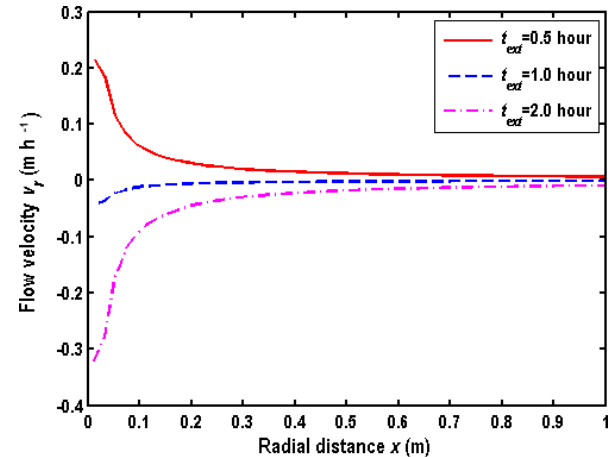
Figure 13. Spatial distribution of the flow velocity in the extraction